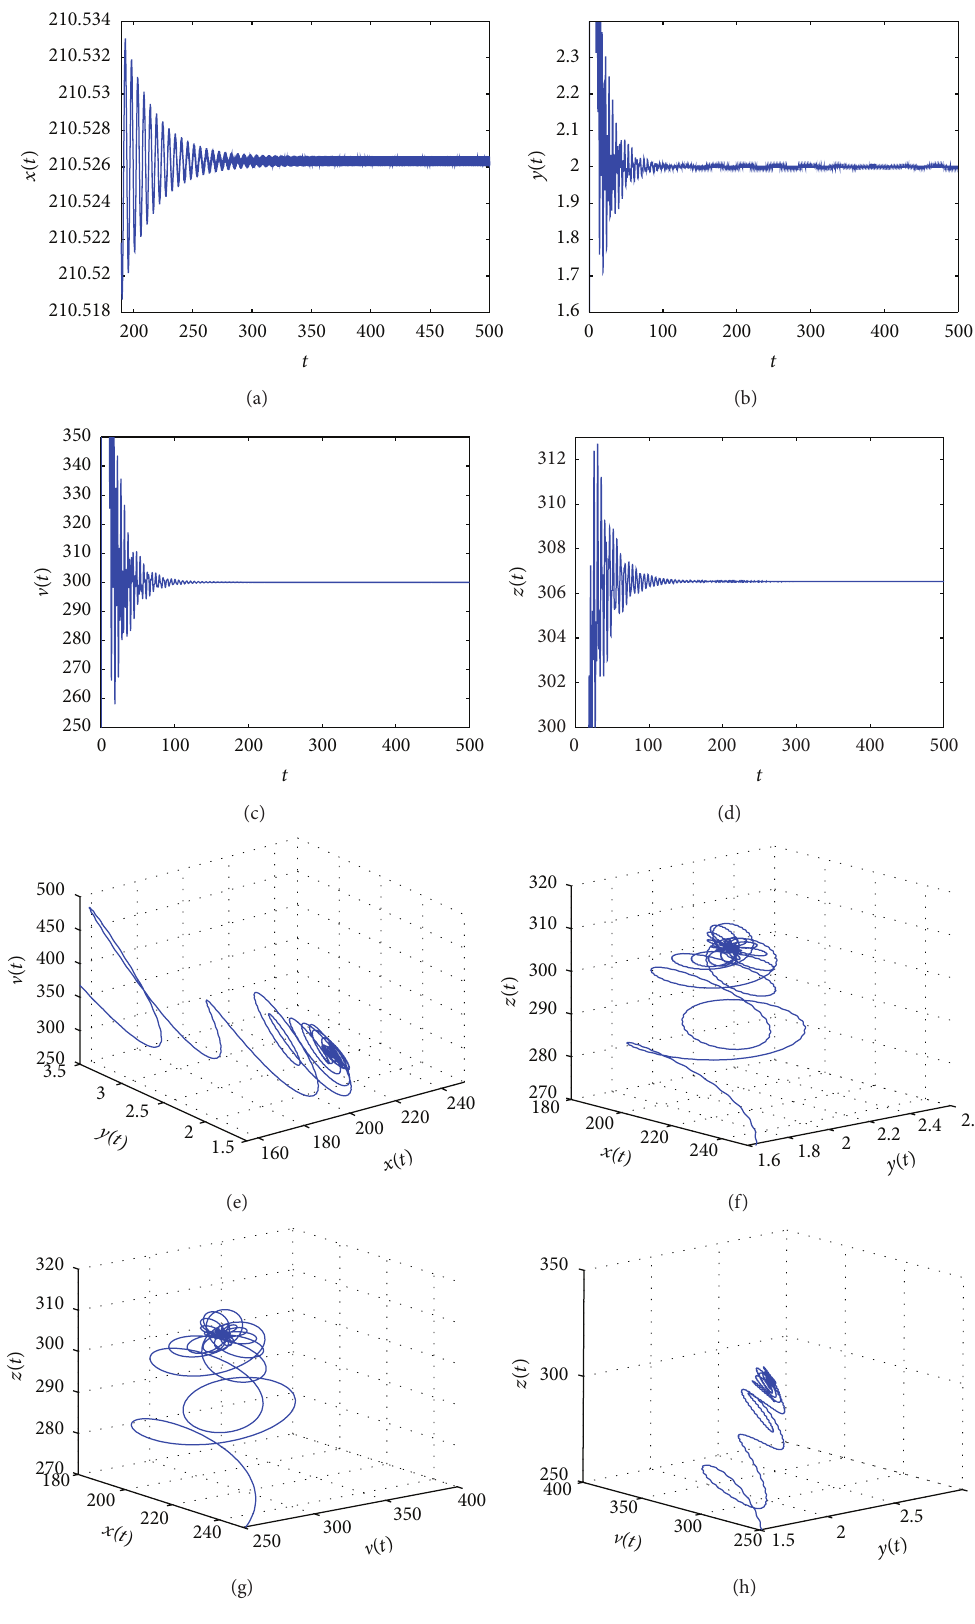
Figure 3: The time histories and the phase trajectories of the system (2) after Hopf bifurcation occurs for 𝜏 2 = 2.55